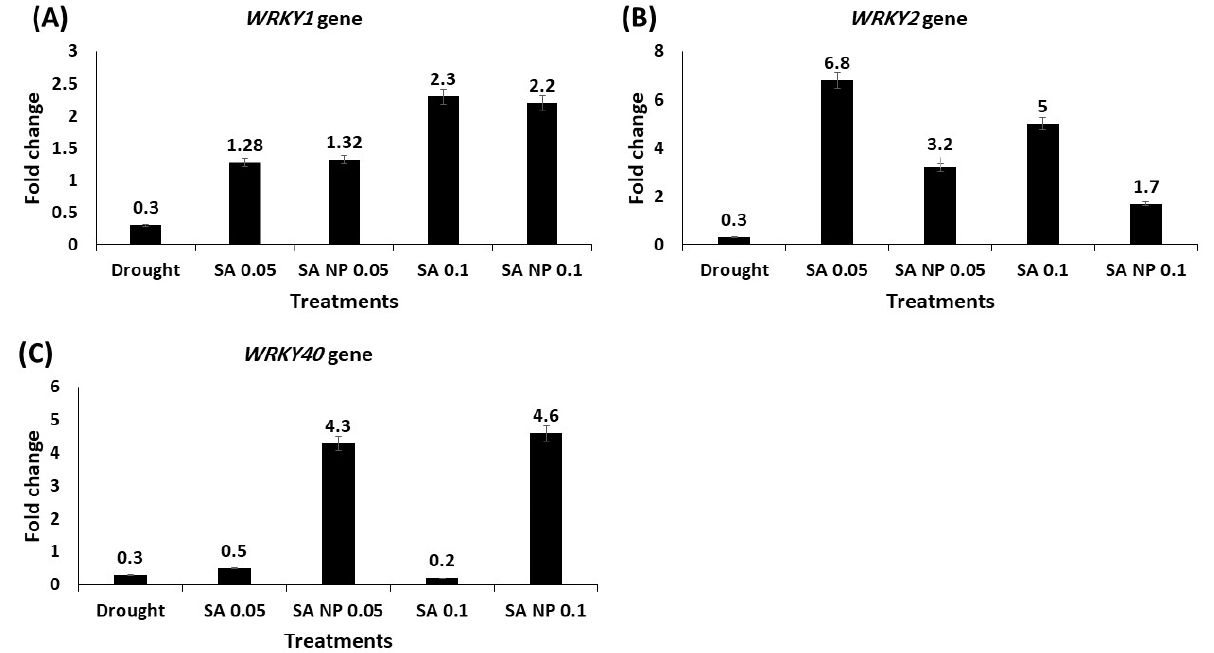
Figure 3. The effect of SANPs and bulk SA at 0.05 and 0.1 mM as a foliar application on the expression profiling of drought-tolerance related genes in Catharanthus roseus leaves of treated plants using qRT-PCR analysis. ( A ) WRKY1 gene; ( B ) WRKY2 gene; ( C ) WRKY40 gene. Data were normalized using the Actin gene (MG813871.1) as an internal reference gene. Error bars represent standard errors.